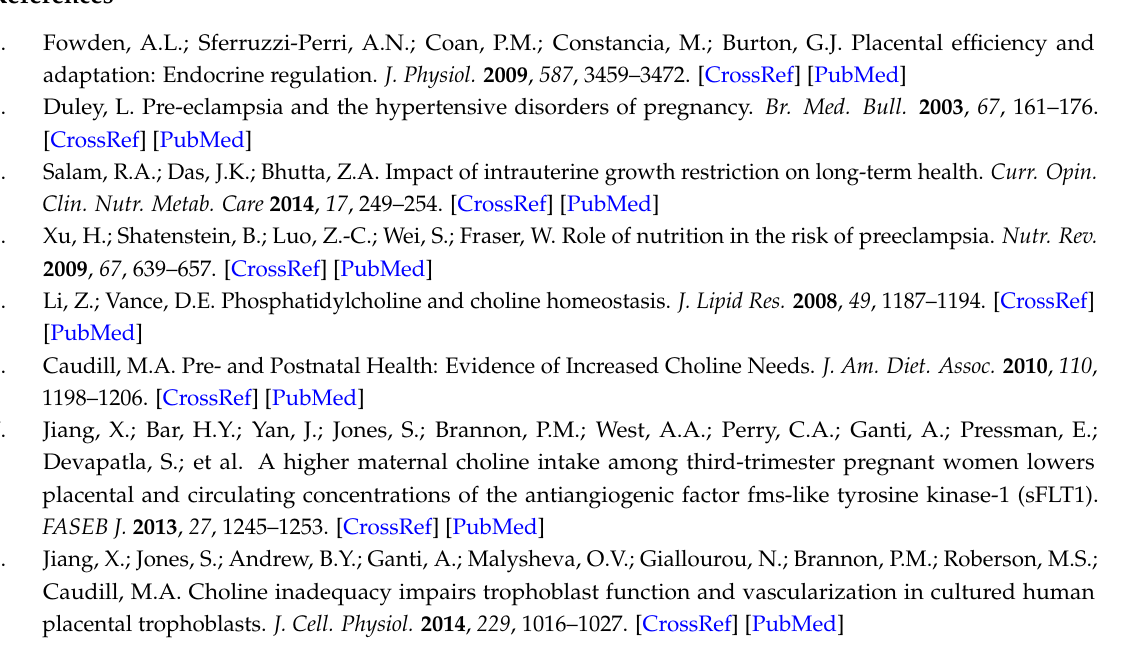
Figure S1: Fetal and placental growth characteristics by Dlx3 genotype, Figure S2: Growth factor gene expression by Dlx3 genotype, Table S1: Primers for genotyping and RT-qPCR, Table S2: Litter size, resorptions, total implantations, and fetal body composition, Table S3: Genotype distributions, Table S4: Fetal and placental growth characteristics at E12.5 and